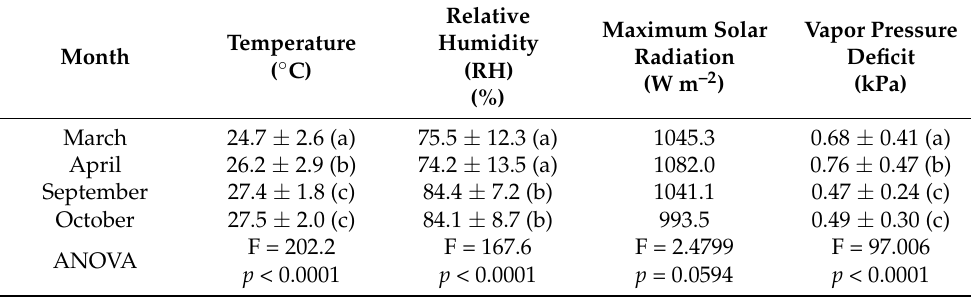
Table 2. Analysis of variance of temperature, radiation, relative humidity, and vapor pressure deficit in a tropical dry deciduous forest in El Palmar State Reserve, Yucatan, Mexico. March and April represent the late dry season; September and October, the late rainy season. Different letters (a, b, c) mark significant differences in the months of sap-flux data acquisition (post-hoc Tukey-Kramer HSD, α = 0.01).